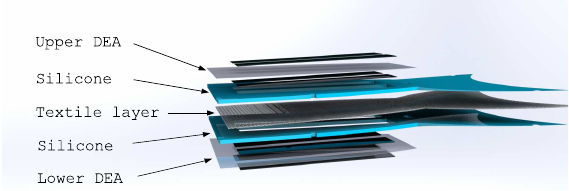
Figure 3. Layered setup of the robot with DEAs on both outer sides and the textile layer in the neutral plane sandwiched between silicone